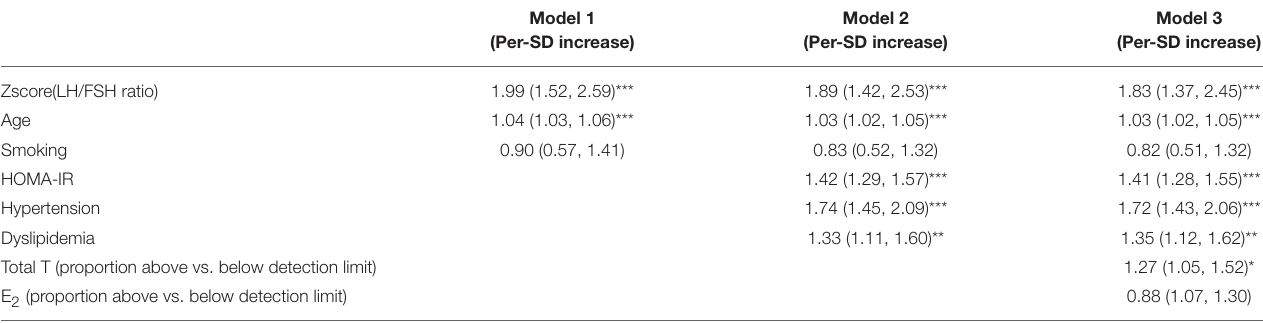
TABLE 4 | Association of LH/FSH ratio with visceral obesity: logistic